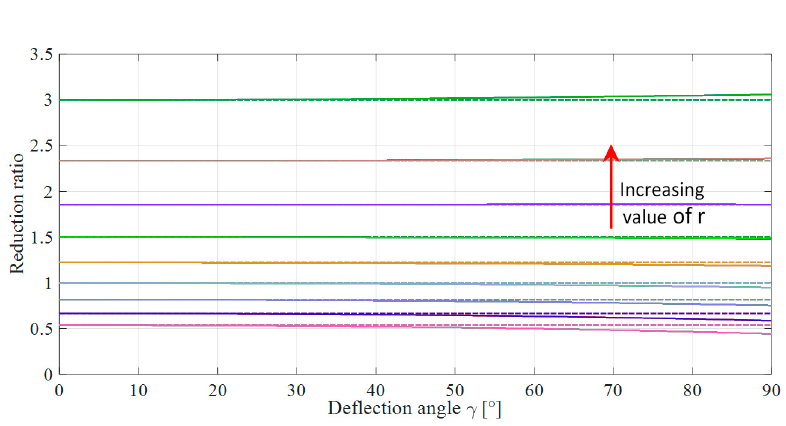
( γ ,r ) and ideally equivalent reducer (IR) in dotted (𝛾, r) and ideally equivalent reducer (IR) in dotted (cid:4666)𝛾, r(cid:4667) and ideally equivalent reducer (IR) in dotted T γ (cid:3021) (cid:3330) (cid:3021) (cid:3330)